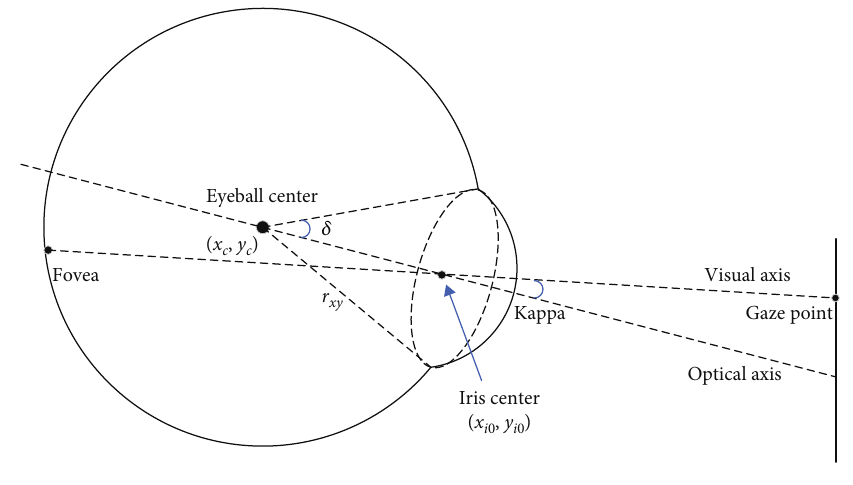
Figure 5: 3D eyeball